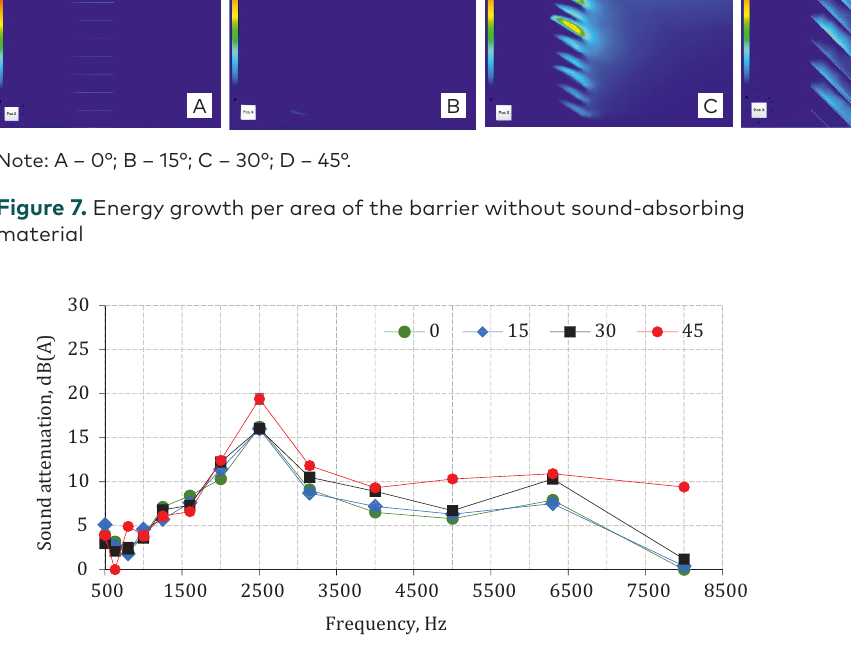
Figure 8. Test results with blades covered with 10 mm thickness of mineral wool on both sides